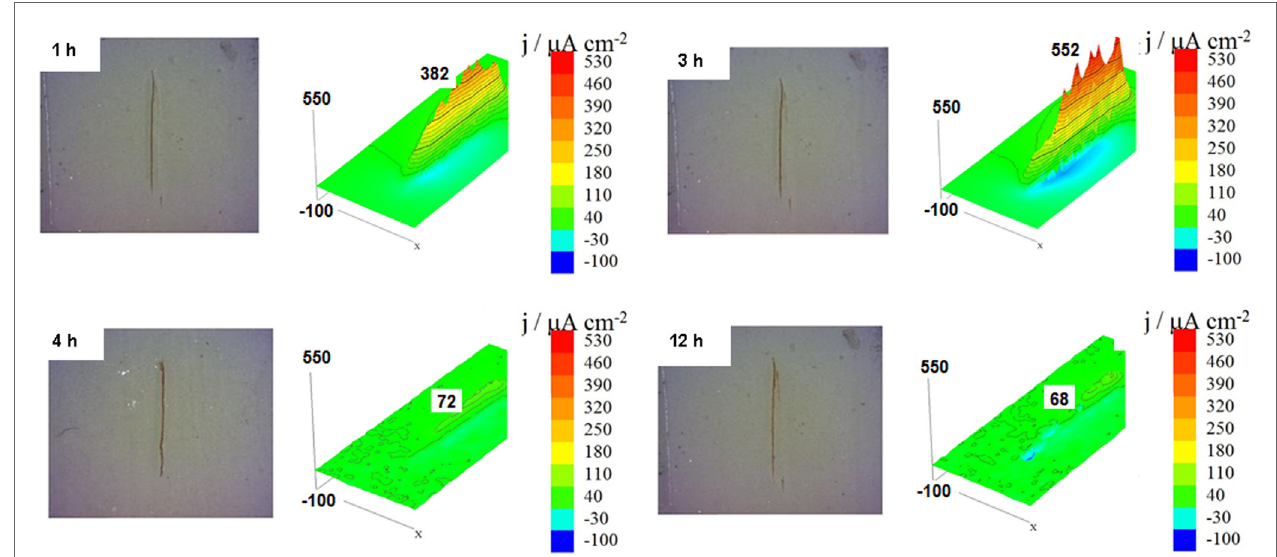
FigUre 10 | scanning vibrating electrode technique maps of the ionic currents measured above the surface of the carbon steel coated with alkyd primer doped with 10 wt.% of halloysite nanotubes loaded with dodecylamine inhibitor obtained after different immersion times in 0.01 mol/l nacl .